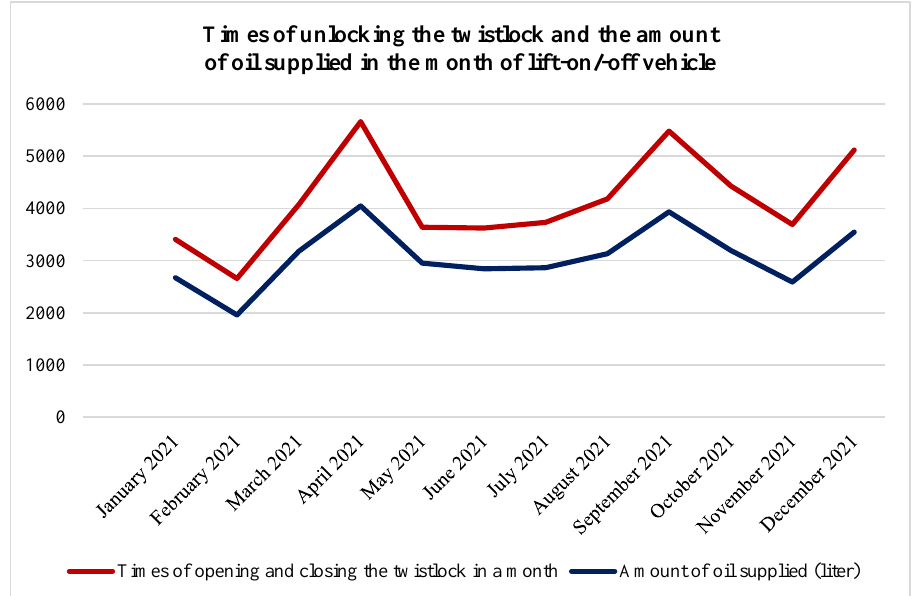
Figure 3. Times of unlocking the twistlock and the amount of oil supplied in the month of lift-on/-off